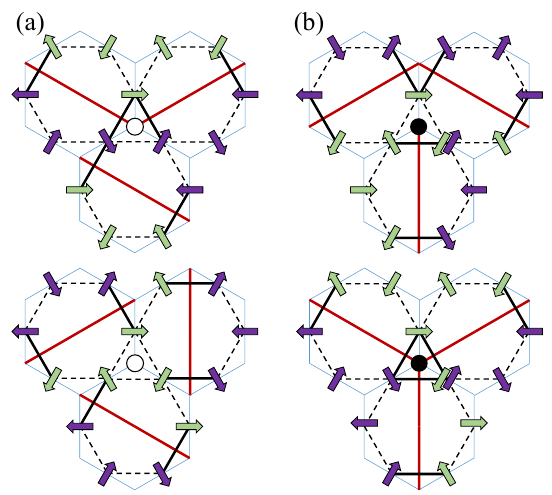
Figure 2: (a) Compatible and (b) incompatible vertices respectively consist of an even or odd number of antiferromagnetic bonds on the corresponding triangular plaquettes of the dual kagome lattice. Black circle indicates a topological mechanical defect. The four depicted interfaces account for all the possible configurations of three hexagons meeting at a vertex, up to rotations and